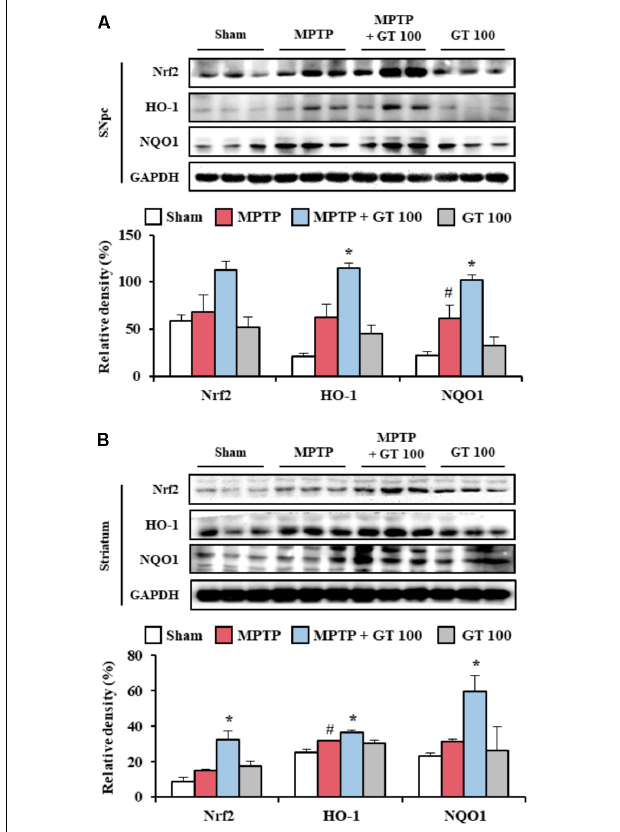
FIGURE 4 | Gintonin activates Nrf2 signaling pathway in the SNpc and striatum after MPTP injection. (A,B) SNpc and striatum sample ( n = 3 per group) 7 days after MPTP-injection were quantified by immunoblot analysis. Nrf2, HO-1, and NQO1. SNpc (A) and striatum (B) . The top panels illustrate representative Western blots. ANOVA test; # p < 0.05 vs. Sham group. ∗ p < 0.05 vs. MPTP